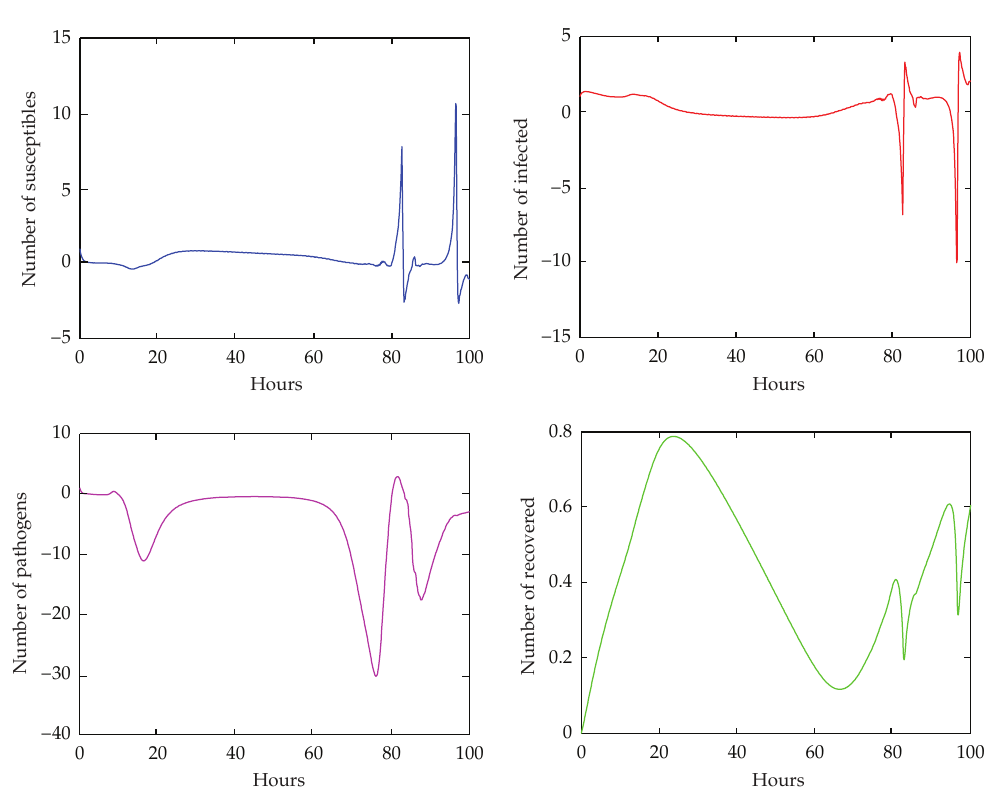
Figure 5: The e ff ect of optimal control with the number of susceptibles, infected individuals, pathogen con- centration, and the recovered individuals.